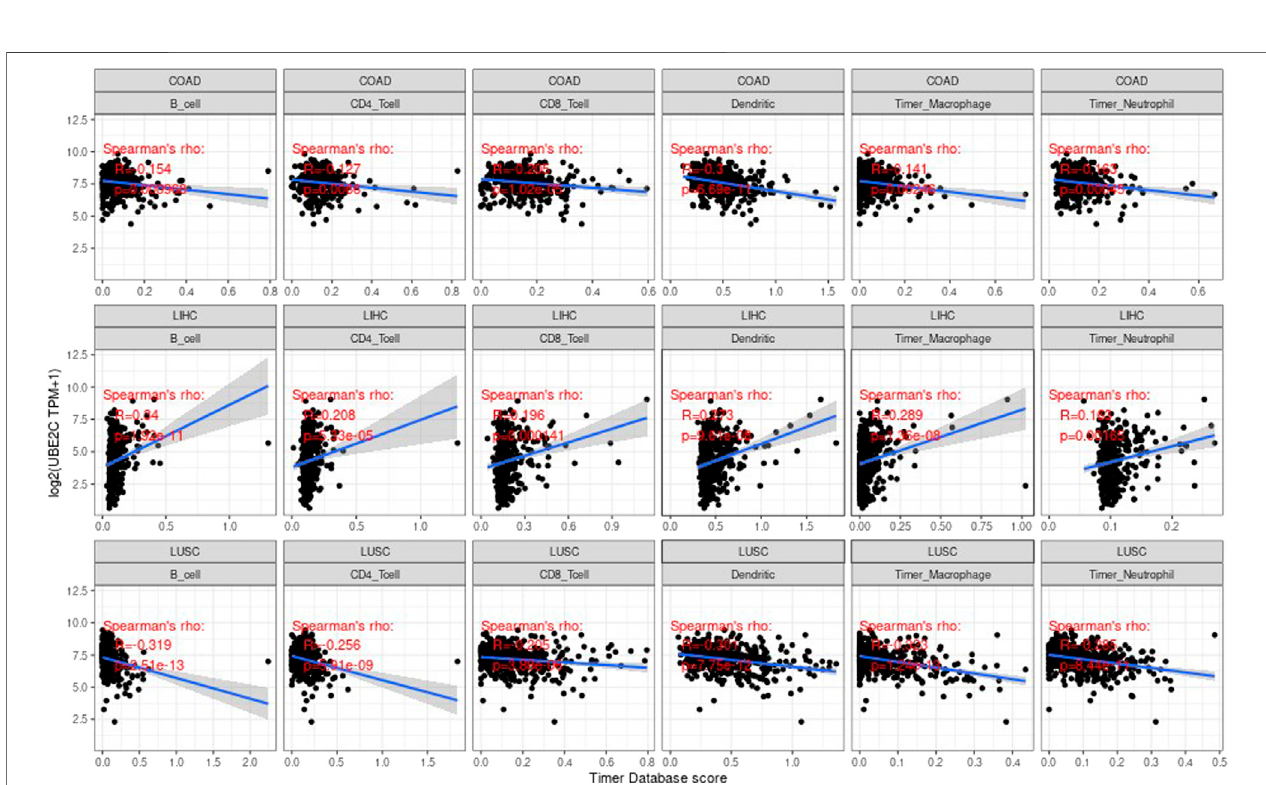
FIGURE 8 | The most signi fi cant expression of the top 3 three tumor immune in fi ltration levels.